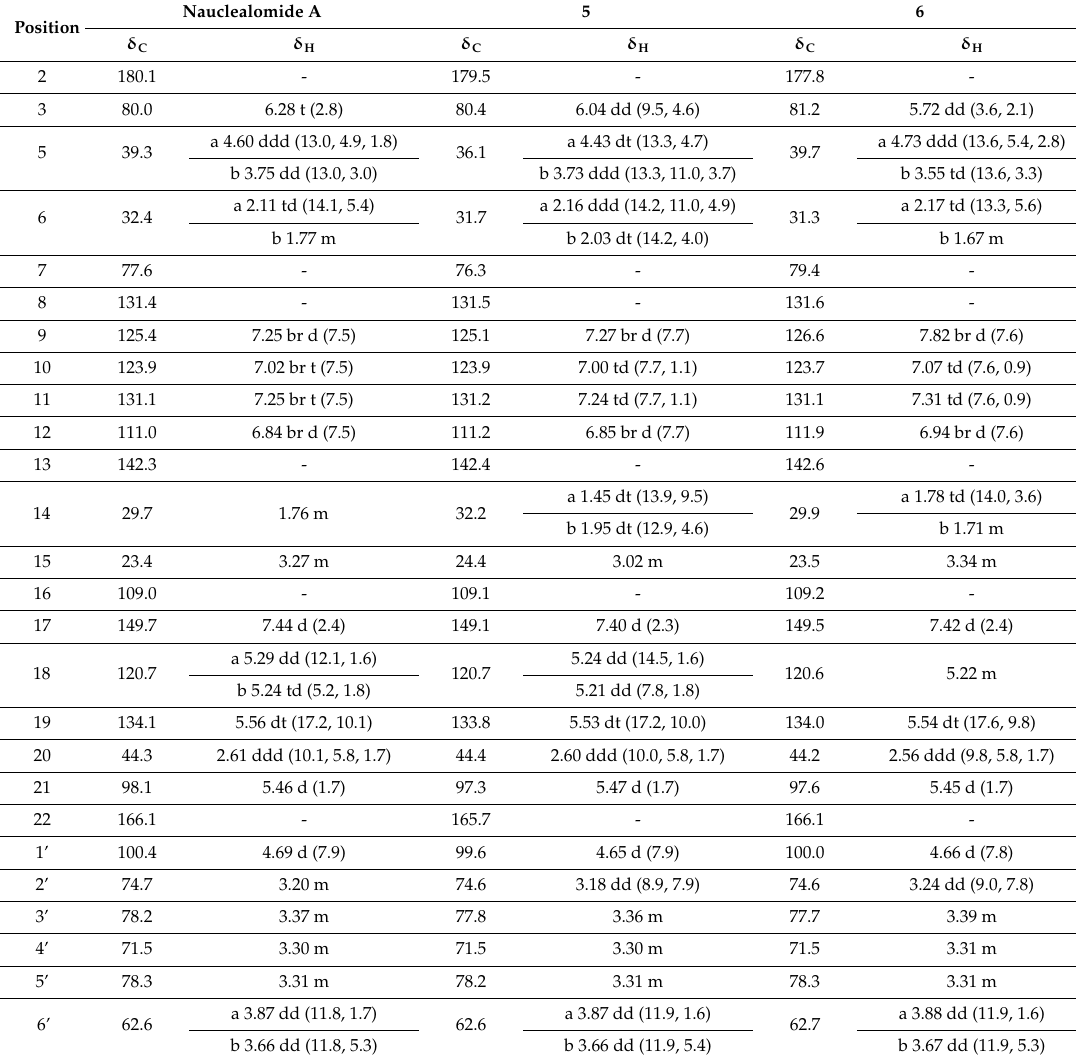
Table 2. 1 H (400 MHz) and 13 C (100 MHz) NMR data of nauclealomide A, 5 and 6 (CD 3 OD, δ in ppm, J in